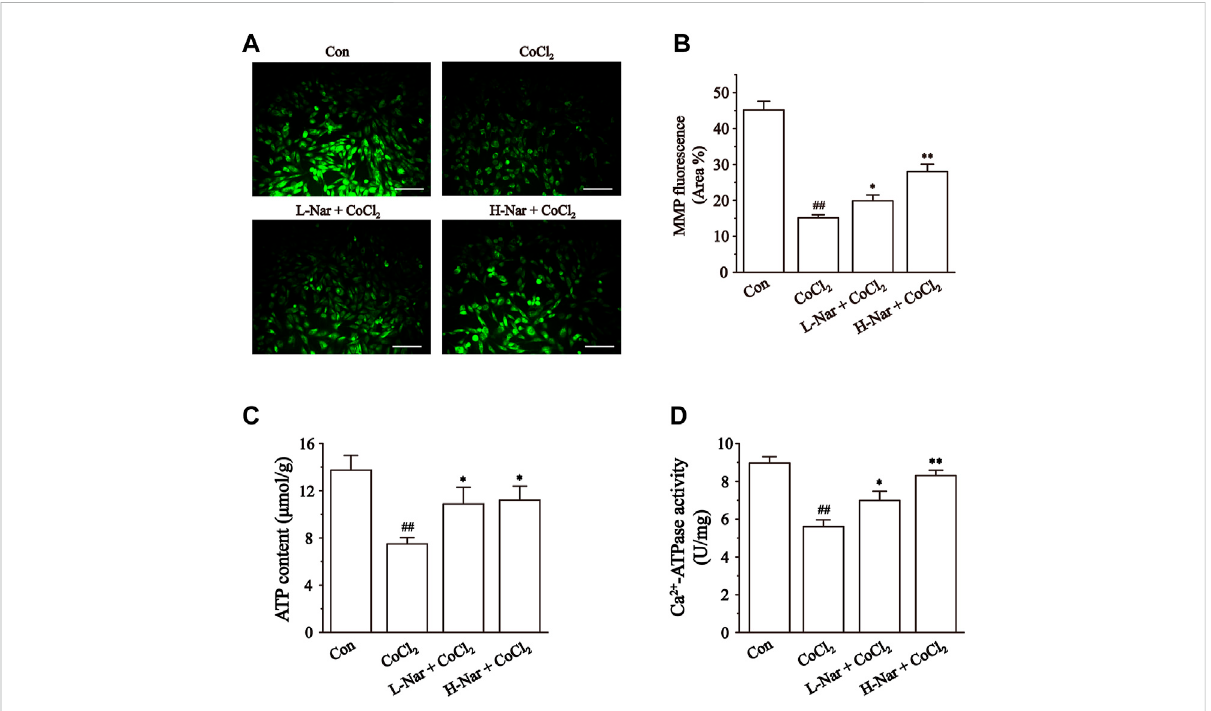
FIGURE 6 Effects of Nar on CoCl 2 -induced the mitochondrial damage in H9c2. (A) Morphological changes of mitochondria were observed by rhodamine 123 (scale bar: 100 μ m; magni fi cation: ×200). (B) Statistical analysis of mitochondrial fl uorescence was presented. (C) ATP content, and (D) Ca 2+ -ATPase activity were detected. Data were expressed as the mean ± SEM of each group. ## p < 0.01 vs. Con group; * p < 0.05, ** p < 0.01 vs.